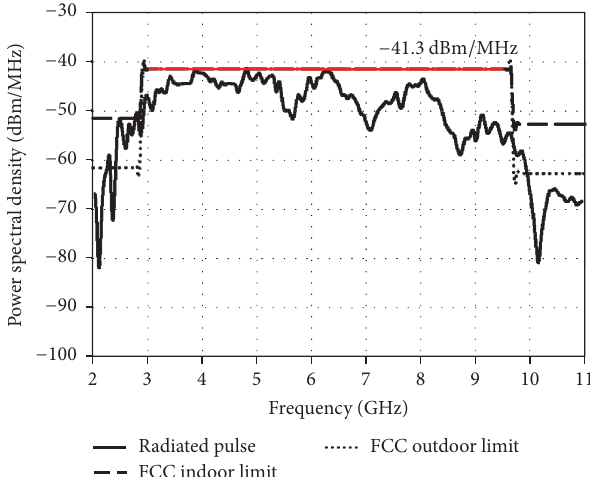
Figure 10: Power spectral density of the radiated pulse for the proposed antenna against the FCC emission mask.